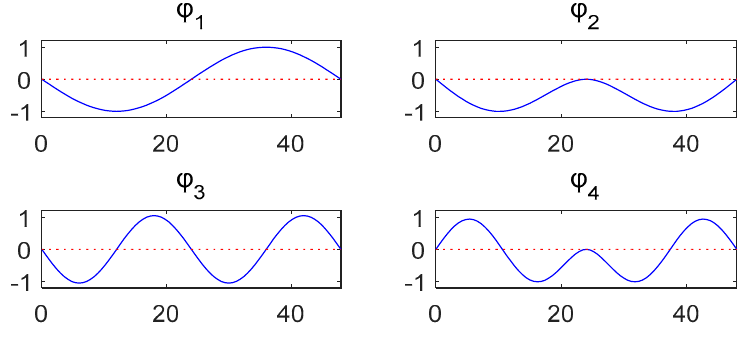
Figure 8. First four modal shapes of the bridge structure. Table 1. First four natural frequencies (Hz).